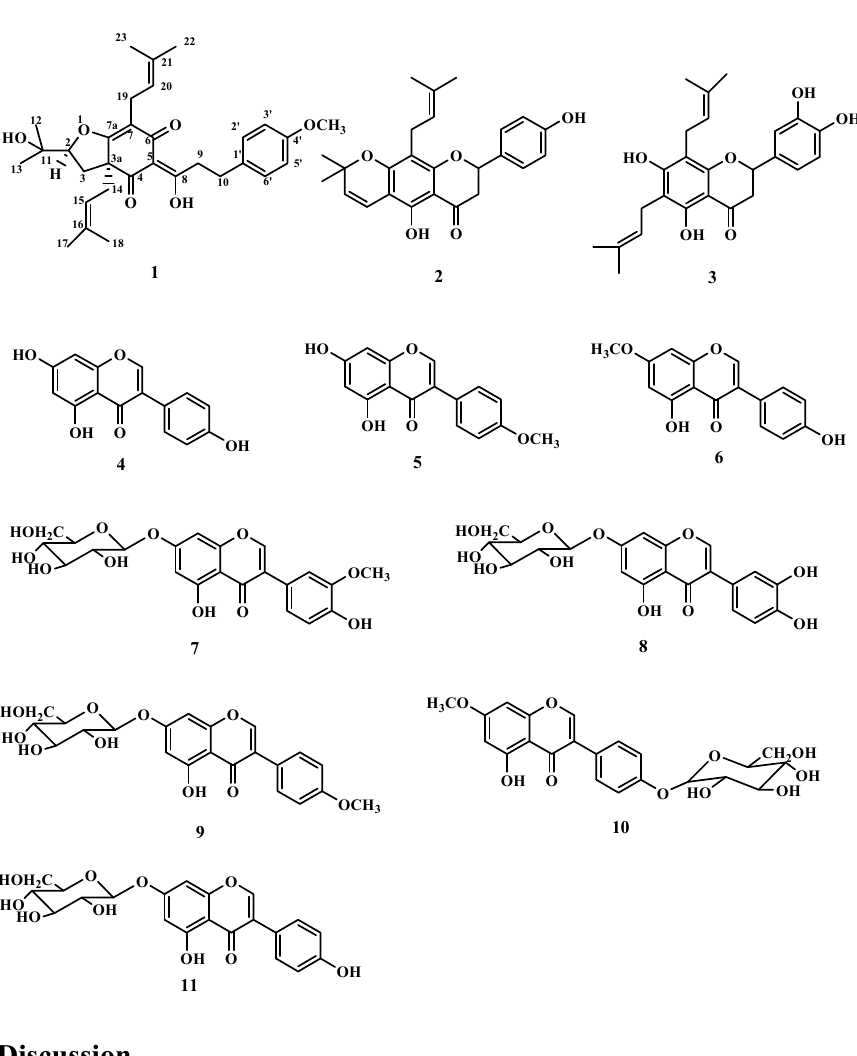
Figure 1. The chemical structures of compounds 1 – 11